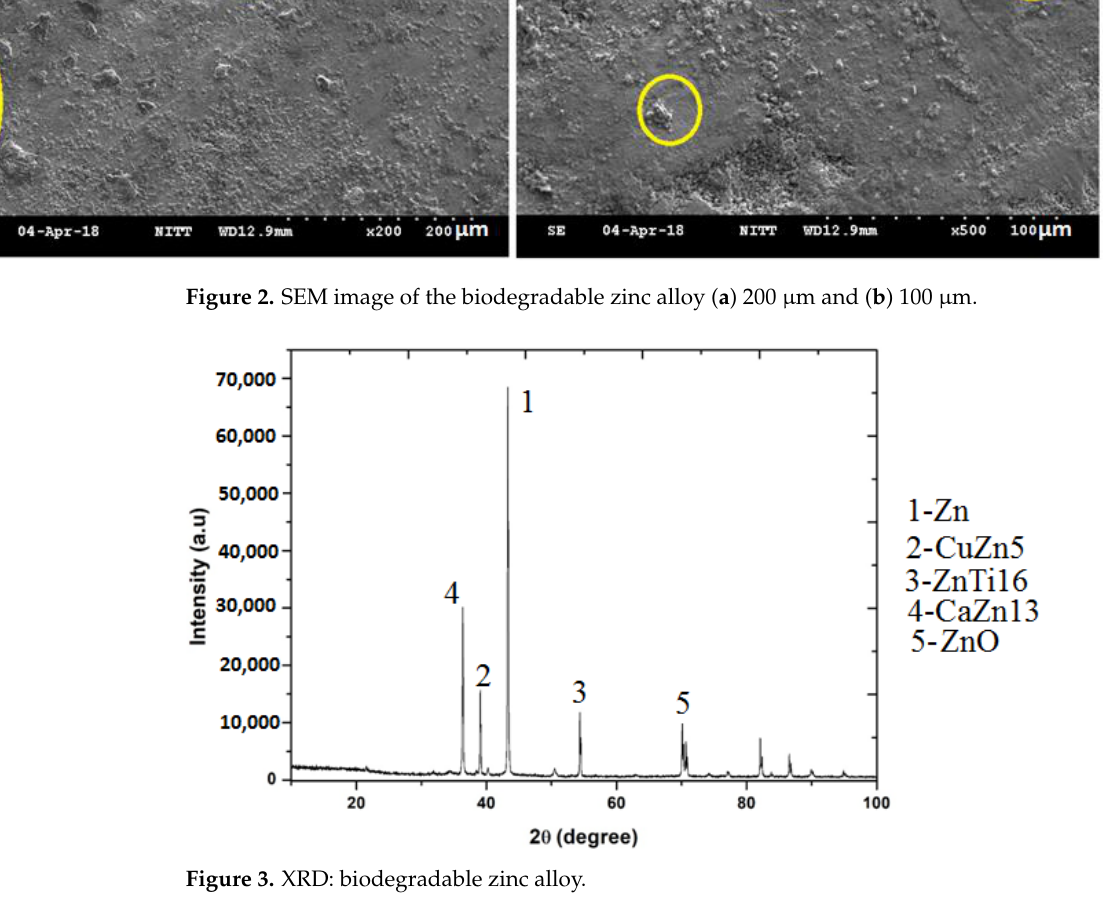
Figure 4. Chemical composition by EDS.